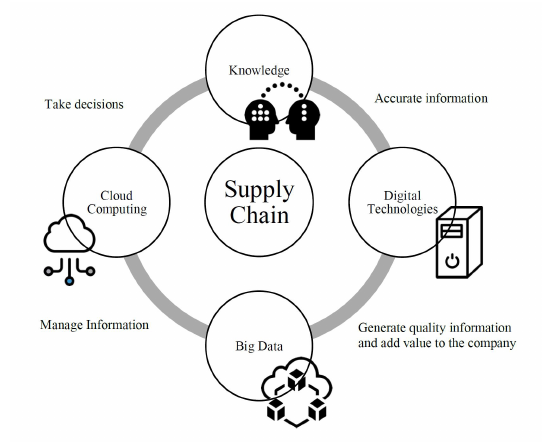
Figure 1. Conceptual Digital Supply Chain.